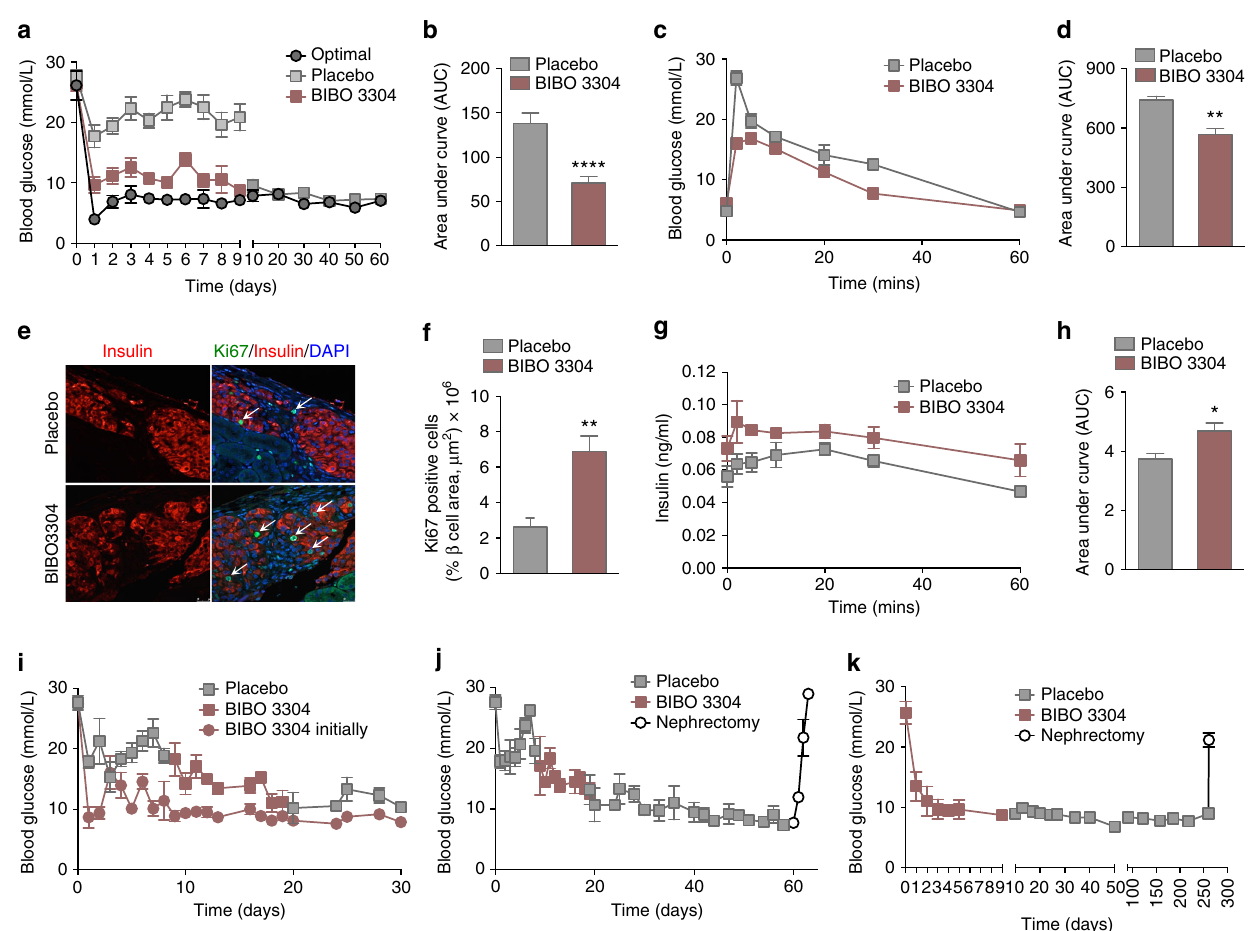
Fig. 2 Improved glycemic control in diabetic mice transplanted with WT islets treated with a Y1 receptor antagonist. a Alloxan-induced diabetic mice were transplanted with an optimal number of WT islets (300) ( n = 6) or 60 WT islets ( n = 12) and treated daily with either 0.5 μ M BIBO3304 ( n = 6) or placebo ( n = 6) for 9 days, respectively, after which BIBO3304 treatment was stopped but blood glucose levels continuously monitored till day 60 post-transplant. b Results for the fi rst 9 days expressed as area under the curve. c , d , g , h Diabetic mice were transplanted with 60 WT islets and subsequently orally treated with 0.5 μ M BIBO3304 or placebo and i.v. glucose tolerance tests (1 g/kg body weight) ( n = 4 per group) were performed at day 5 post-transplant. Blood glucose levels and insulin production were monitored. Results are also expressed as area under the curve. e Representative photomicrographs of islet transplant grafts from placebo and BIBO3304-treated mice showing immuno fl uorescent staining for insulin ( red ), Ki67 ( green ) and nucleus counterstained with DAPI ( blue ). Arrows indicate Ki67-positive β -cells. f Quanti fi cation of Ki67-positive β -cells in grafts of placebo or BIBO3304-treated mice ( n = 3). i , j Diabetic mice were transplanted with 60 WT islets ( n = 10 per group) and half of the mice were treated with 0.5 μ M BIBO3304 from day 1, and the other half were treated with placebo. Mice originally receiving placebo were then treated with 0.5 μ M BIBO3304 from day 9 for 10 days, after which treatment was discontinued. Blood glucose levels were monitored till day 60 after which survival nephrectomy was performed. k Diabetic mice were transplanted with 60 WT islets ( n = 10) and treated with 0.5 μ M BIBO3304 for 9 days after which treatment was discontinued. Blood glucose levels were monitored till day 260 after which survival nephrectomy was performed. Data are shown as mean ± s.e.m. * P < 0.05, ** P < 0.01, calculated by t -test ( b , d , f , h ) or two-way ANOVA analysis (Fig. 3d, e). This improved glycemic control in BIBO3304-treated mice was accompanied by increasedcirculating human insulin levels (Fig. 3f). Together these data demonstrate that the action of Y1 receptor signaling to modulate insulin secretion is conserved in human islet physiology.